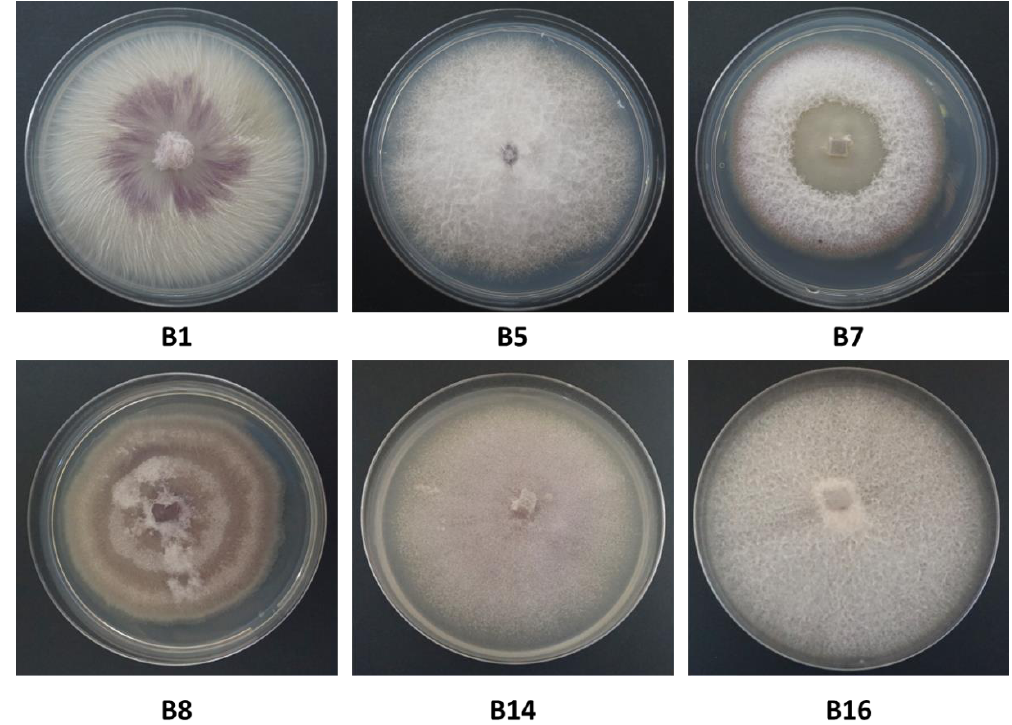
Figure 4. Colony morphology of the Fusarium spp. isolates. Strain designation and data are given in Table 2. Colonies were grown on potato dextrose agar (PDA; Difco Laboratories, Detroit, MI, USA) medium (prepared from the same batch) for seven days at 28 ± 1 °C in the dark.